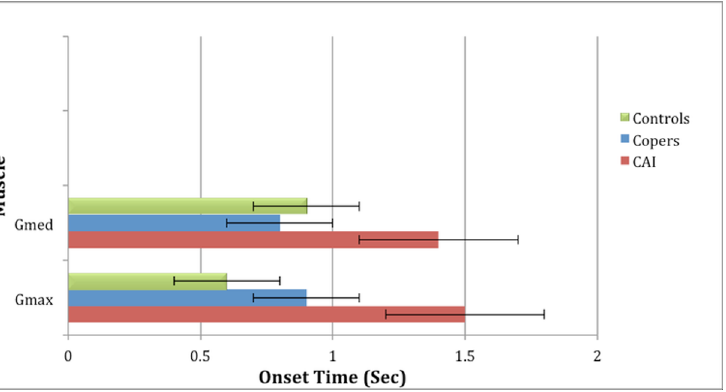
Fig 2. Mean onset time in seconds of gluteus maximus—Gmax (anterior direction) and gluteus medius—Gmed (posteromedial direction) among study groups.